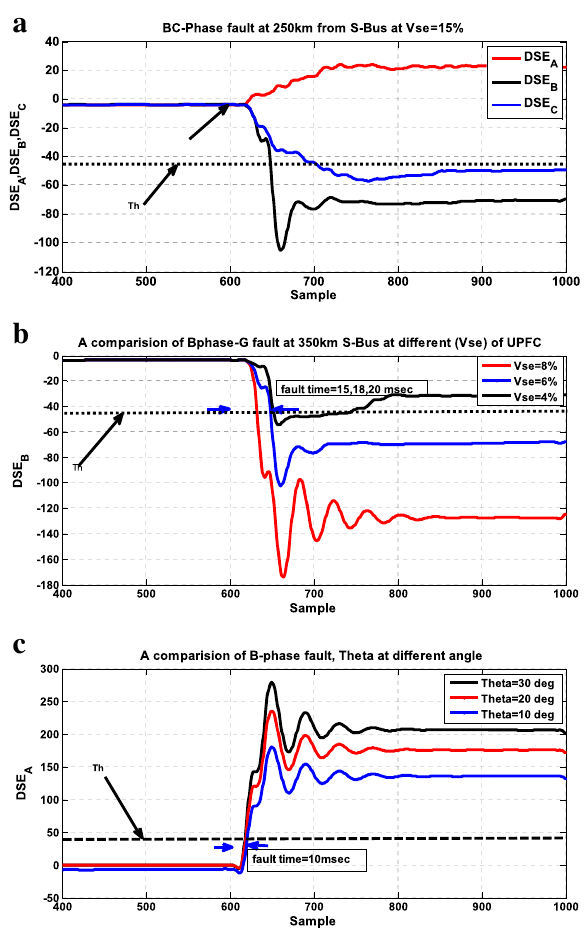
Fig. 8 a . BC-phase fault at 250 km from B-S and V se = 15% increase in Vse. b . A comparison of B phase-G fault at 350 km from B-S at different V se = 8%, 6% and 4% increase in Vse. c . A comparison of B phase-G fault at 350 km from B-S at different θ se value & θ se = 10 0 , 20 0 & 30 0